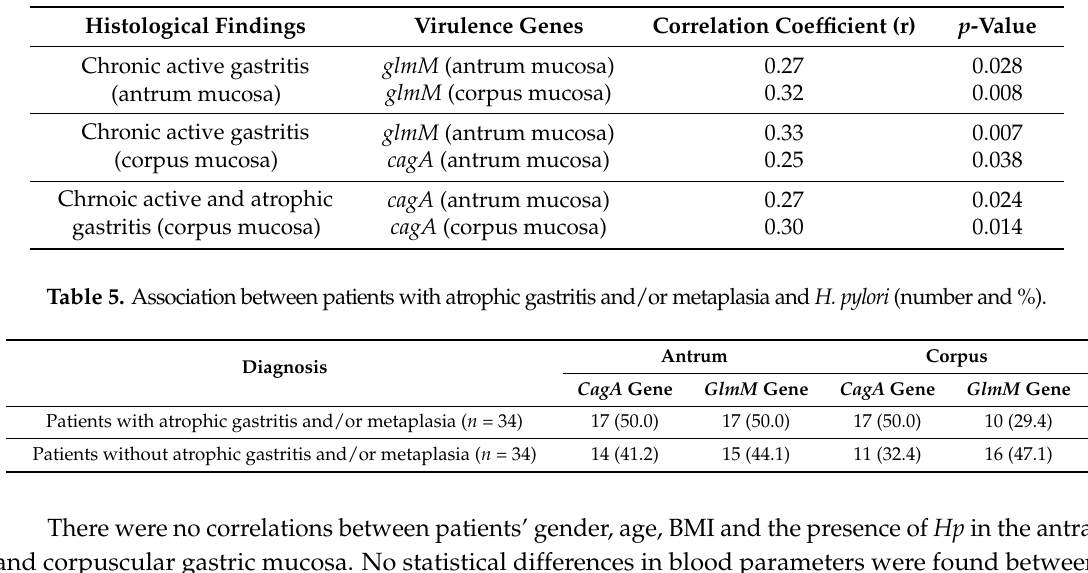
Table 6. Blood parameters of patients with and without H. pylori infection (mean ± SD, range).